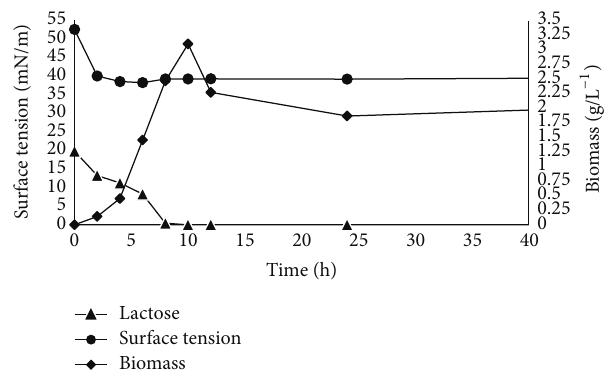
Figure 1: Experimental data of extracellular surface tension varia- tion, biomass, and lactose concentration obtained from fermenta-